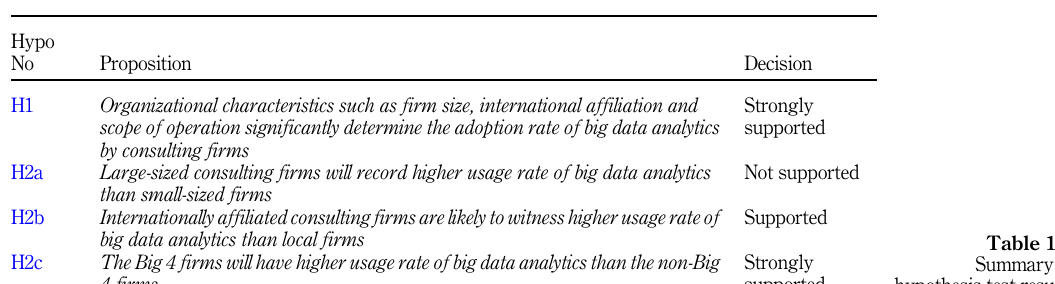
Table 14. Summary